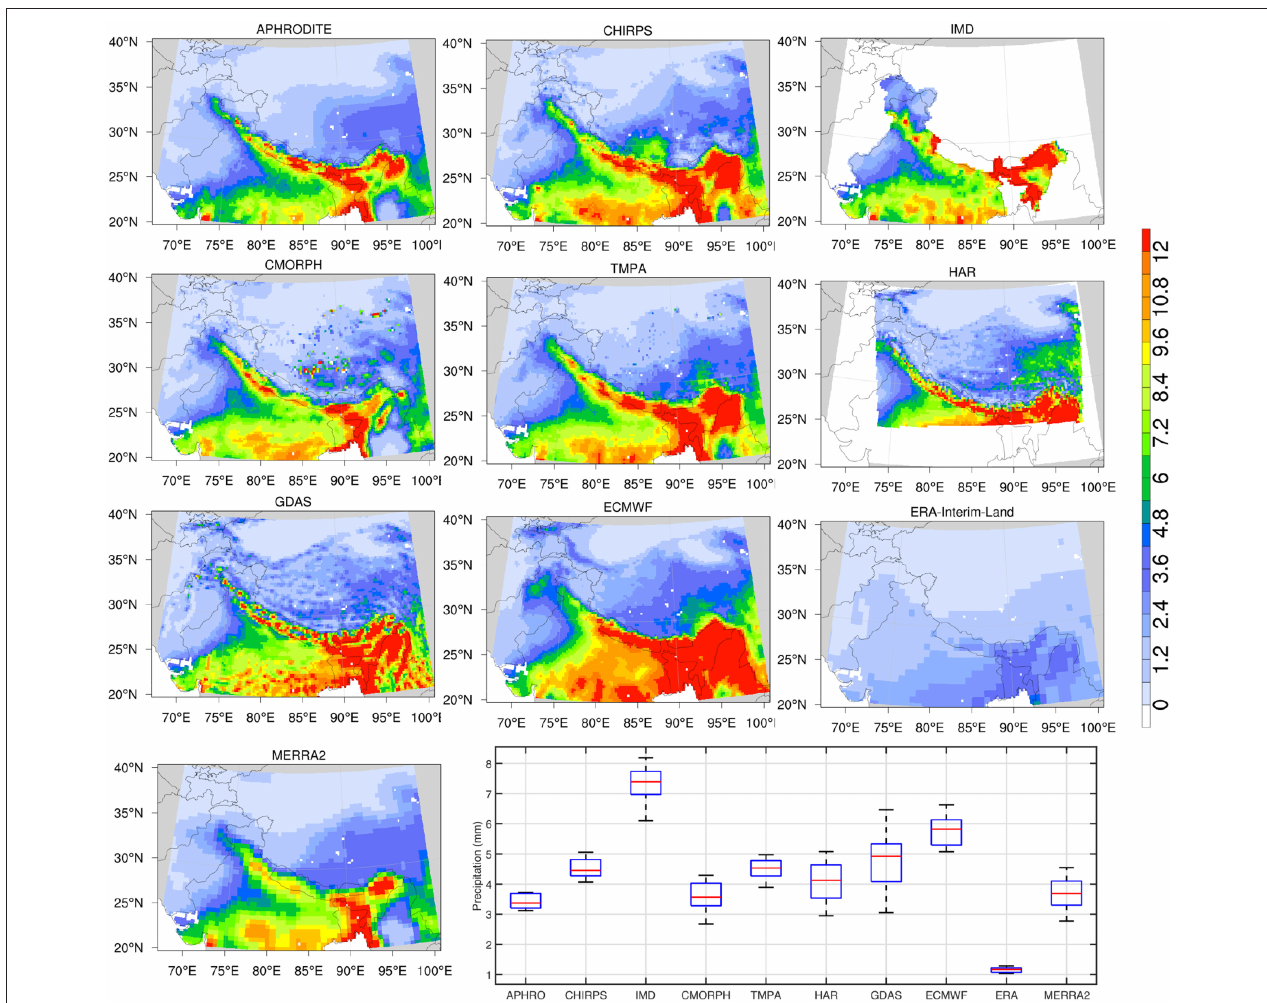
FIGURE 5 | Same as Figure 2 , but stratified for the summer months (June, July, August). The extreme data points/outliers are plotted individually using the “+”